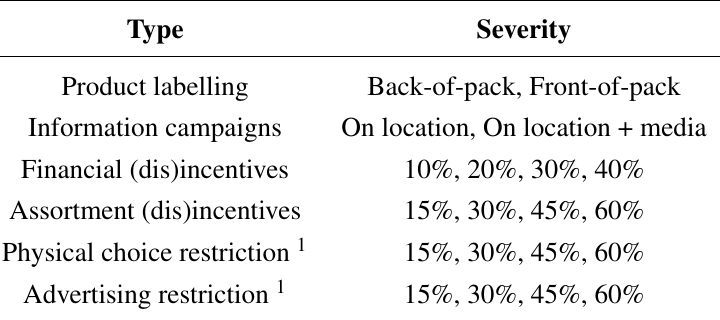
Table 2. Intervention type and severity